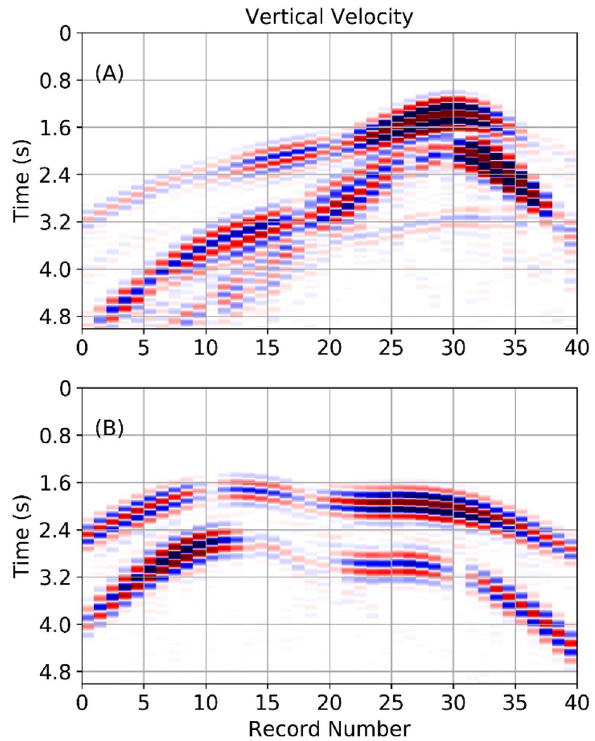
Figure 2. 40 synthetic seismic sensors are distributed across the surface of all models. The seismogram amplitudes are normalised. This example shows synthetic vertical seismic traces for the sample from population L in panel ( A ) and population T in panel ( B ). See also Fig. 1. A random selection of 10 sensors is used in FNO